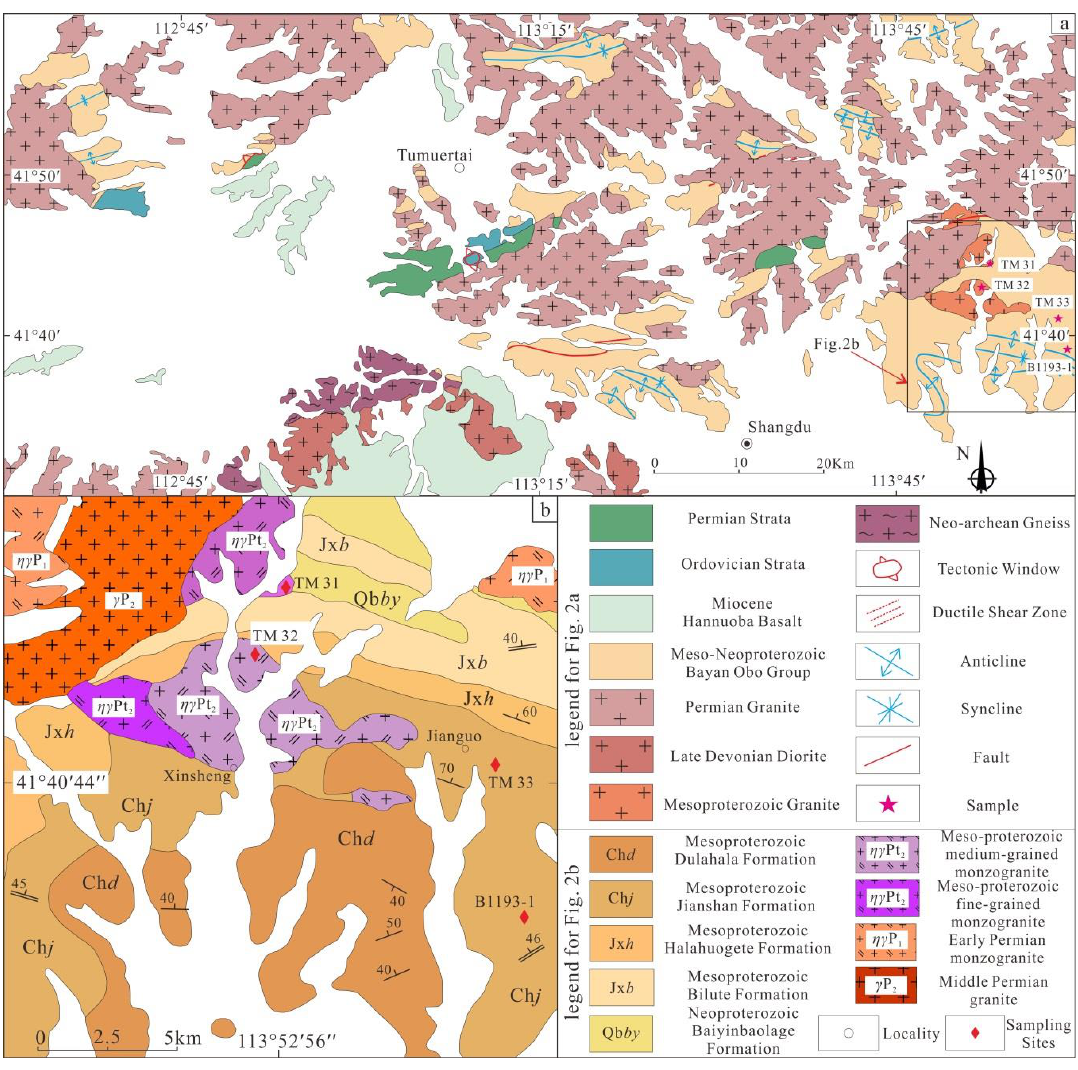
Figure 2. Simplified geological map of the study area. ( a ) Geological map of the Shangdu Area (after [51]); ( b ) sketch geological map of the sampling area.